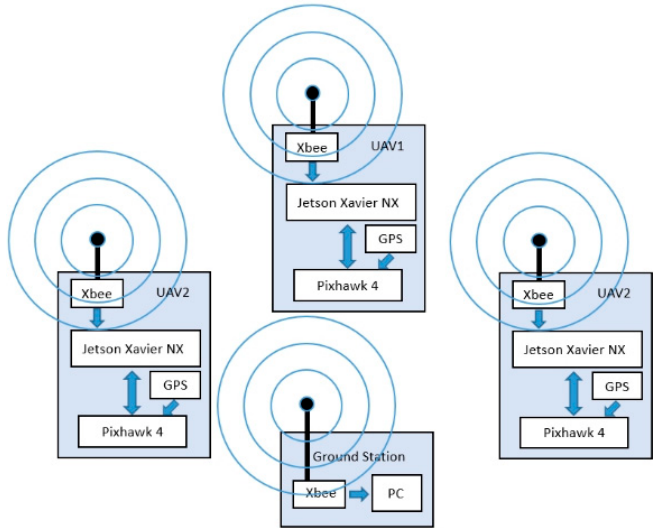
Figure 2. System schematic.